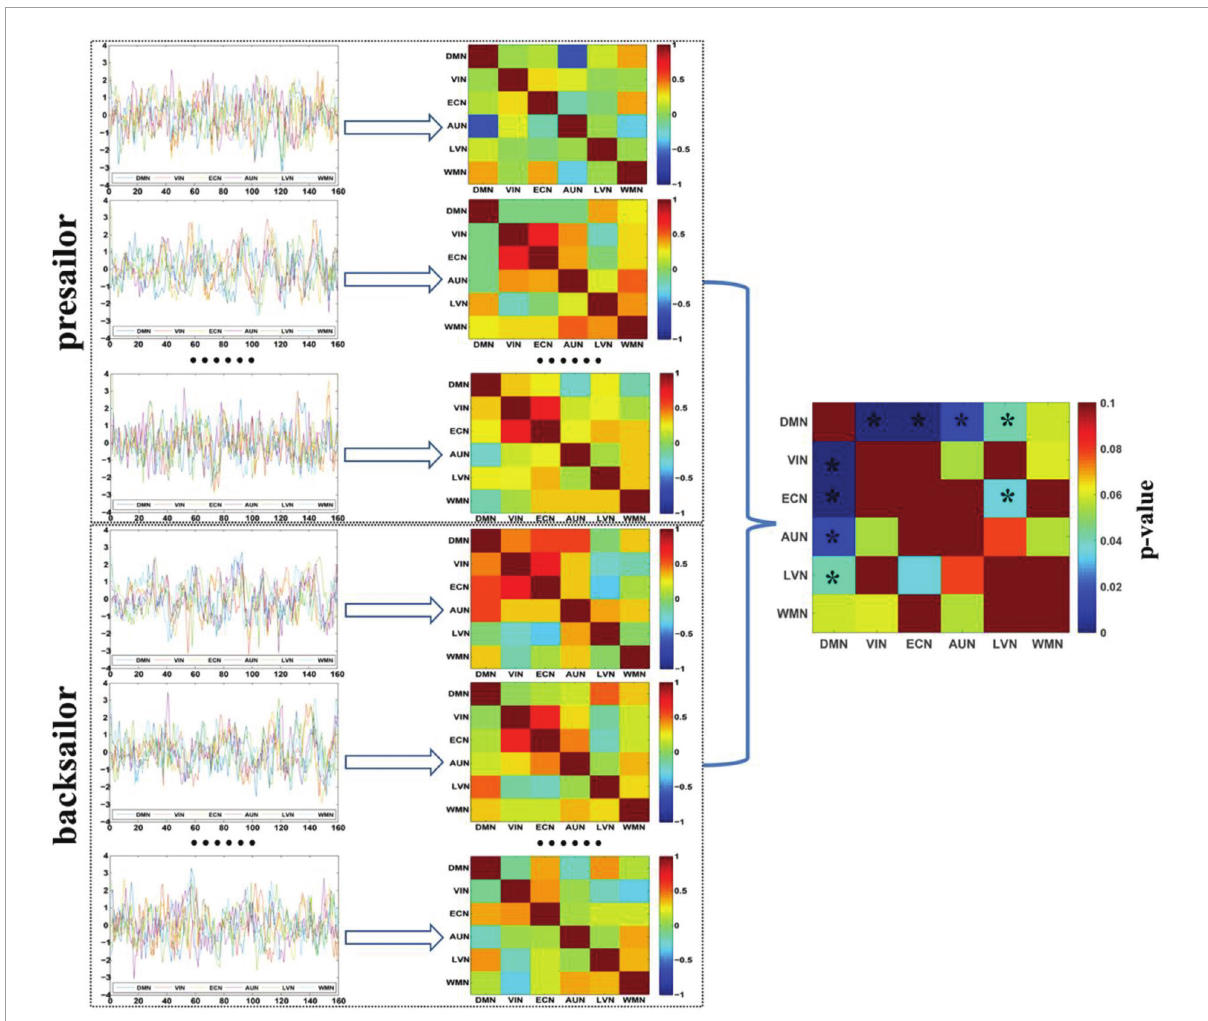
FIGURE5 The SFCs among the six resting-state brain functional networks of seafarers before and after sailing at the individual level and the statistical analysis results of SFCs between seafarers before and after sailing for each pair of brain networks. The asterisk indicates that there is a significant difference with a confidence level of p <